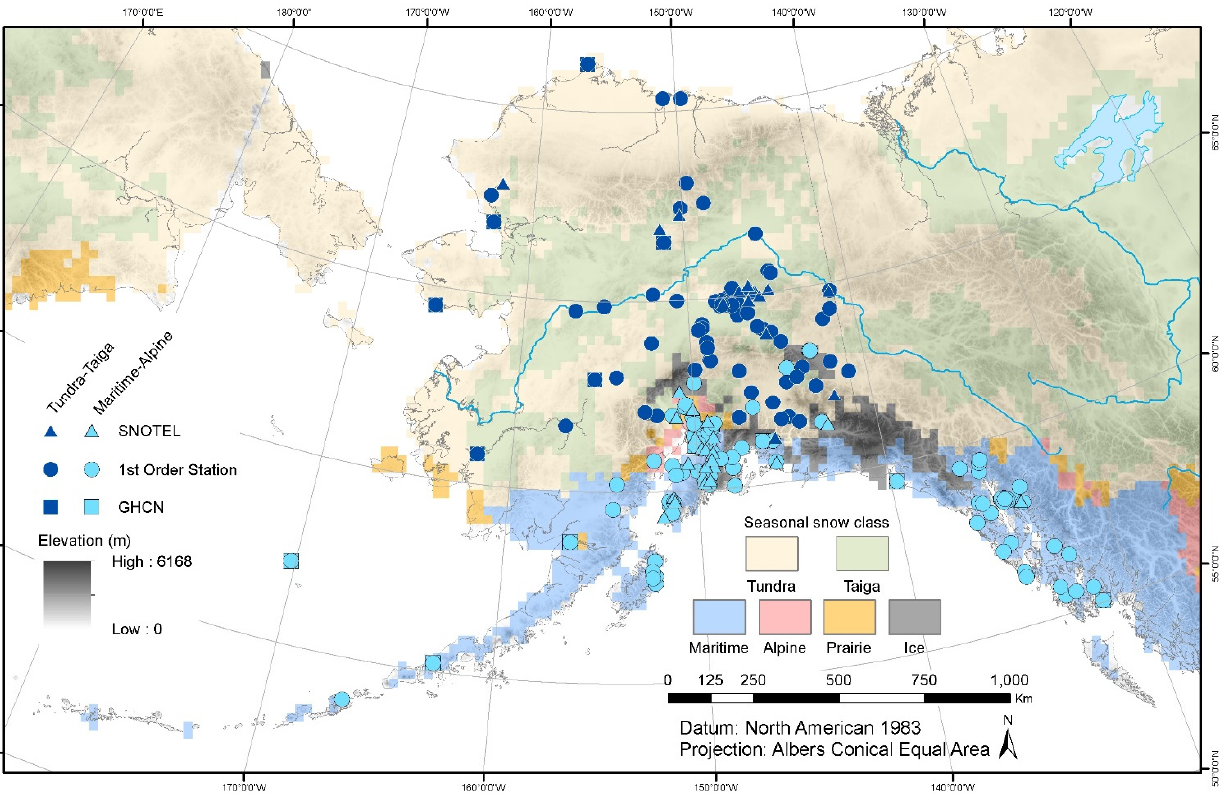
Figure 1. Study area showing locations of in situ snow onset and melt dates for Alaska with respect to seasonal snow class [32]. In situ weather station locations are grouped as Tundra/Taiga and Maritime/Alpine to differentiate between colder, drier conditions to the north and warmer, wetter conditions along the southern coast,